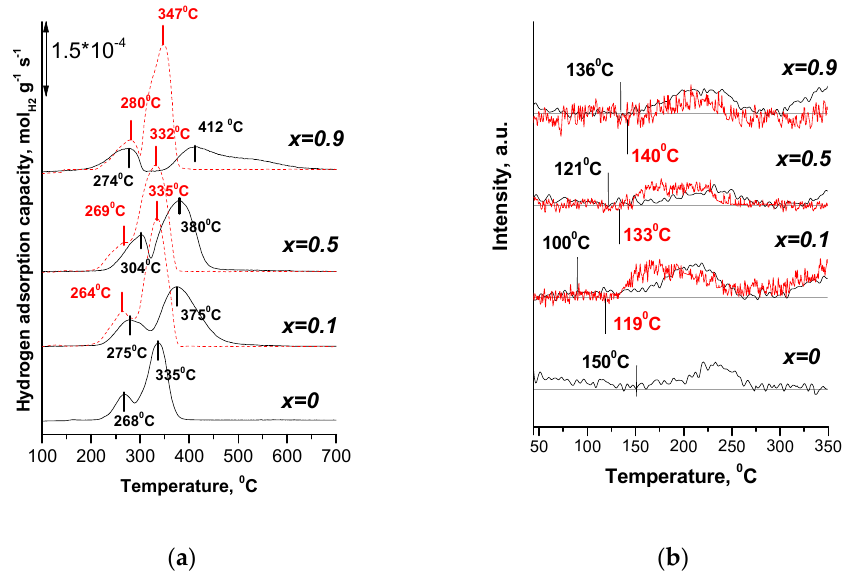
Figure 2. Profiles of the Cs/Mg-Co (black) and Cs/Ni-Co (red) samples obtained by ( a ) H 2 -TPR and ( b ) O 2 -TPD.